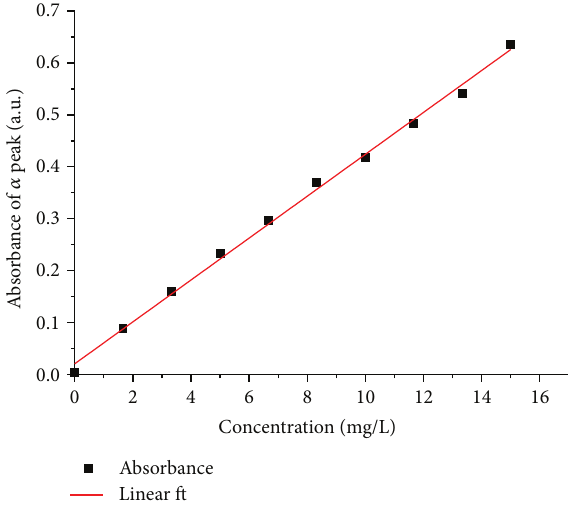
Figure 7: Calibration curve for the vanadium (IV) etioporphyrin III oxide solution in acetone using the height of the absorbance of the 𝛼 peak as a function of the concentration.